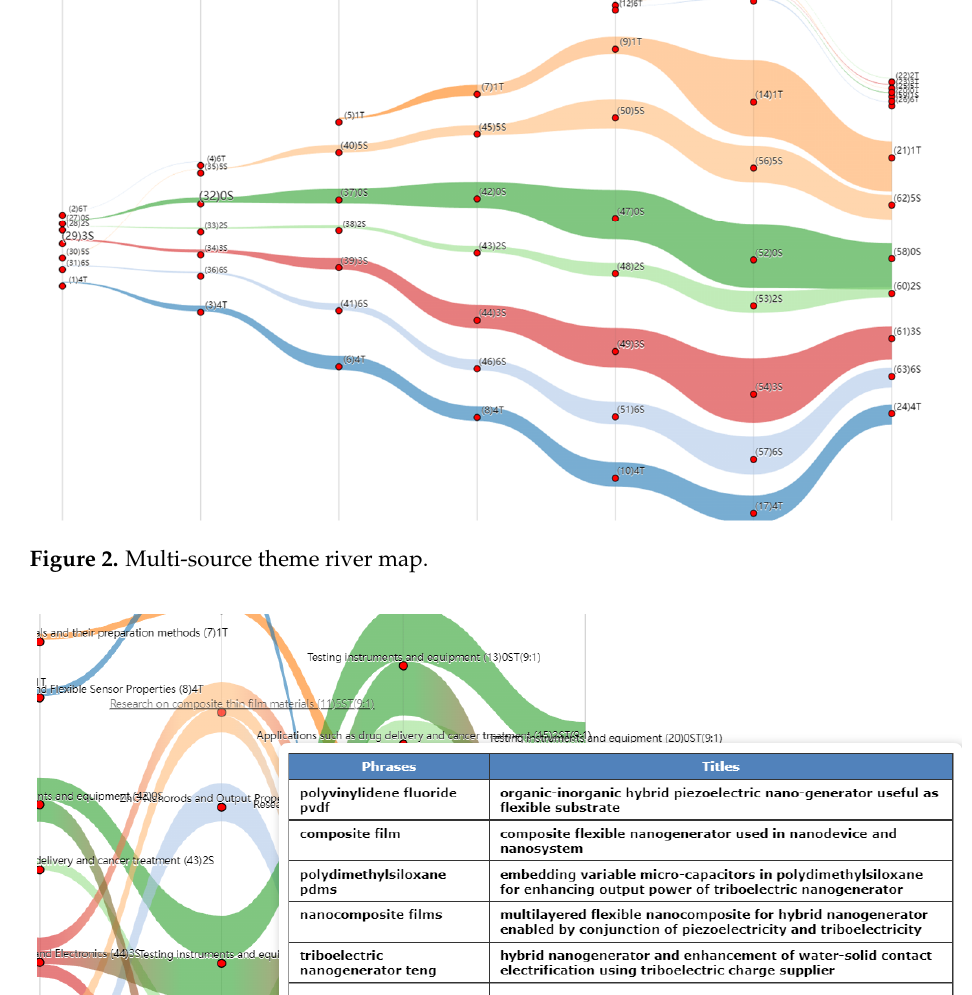
Table 2. Theme modeling results of multi-source fusion texts.